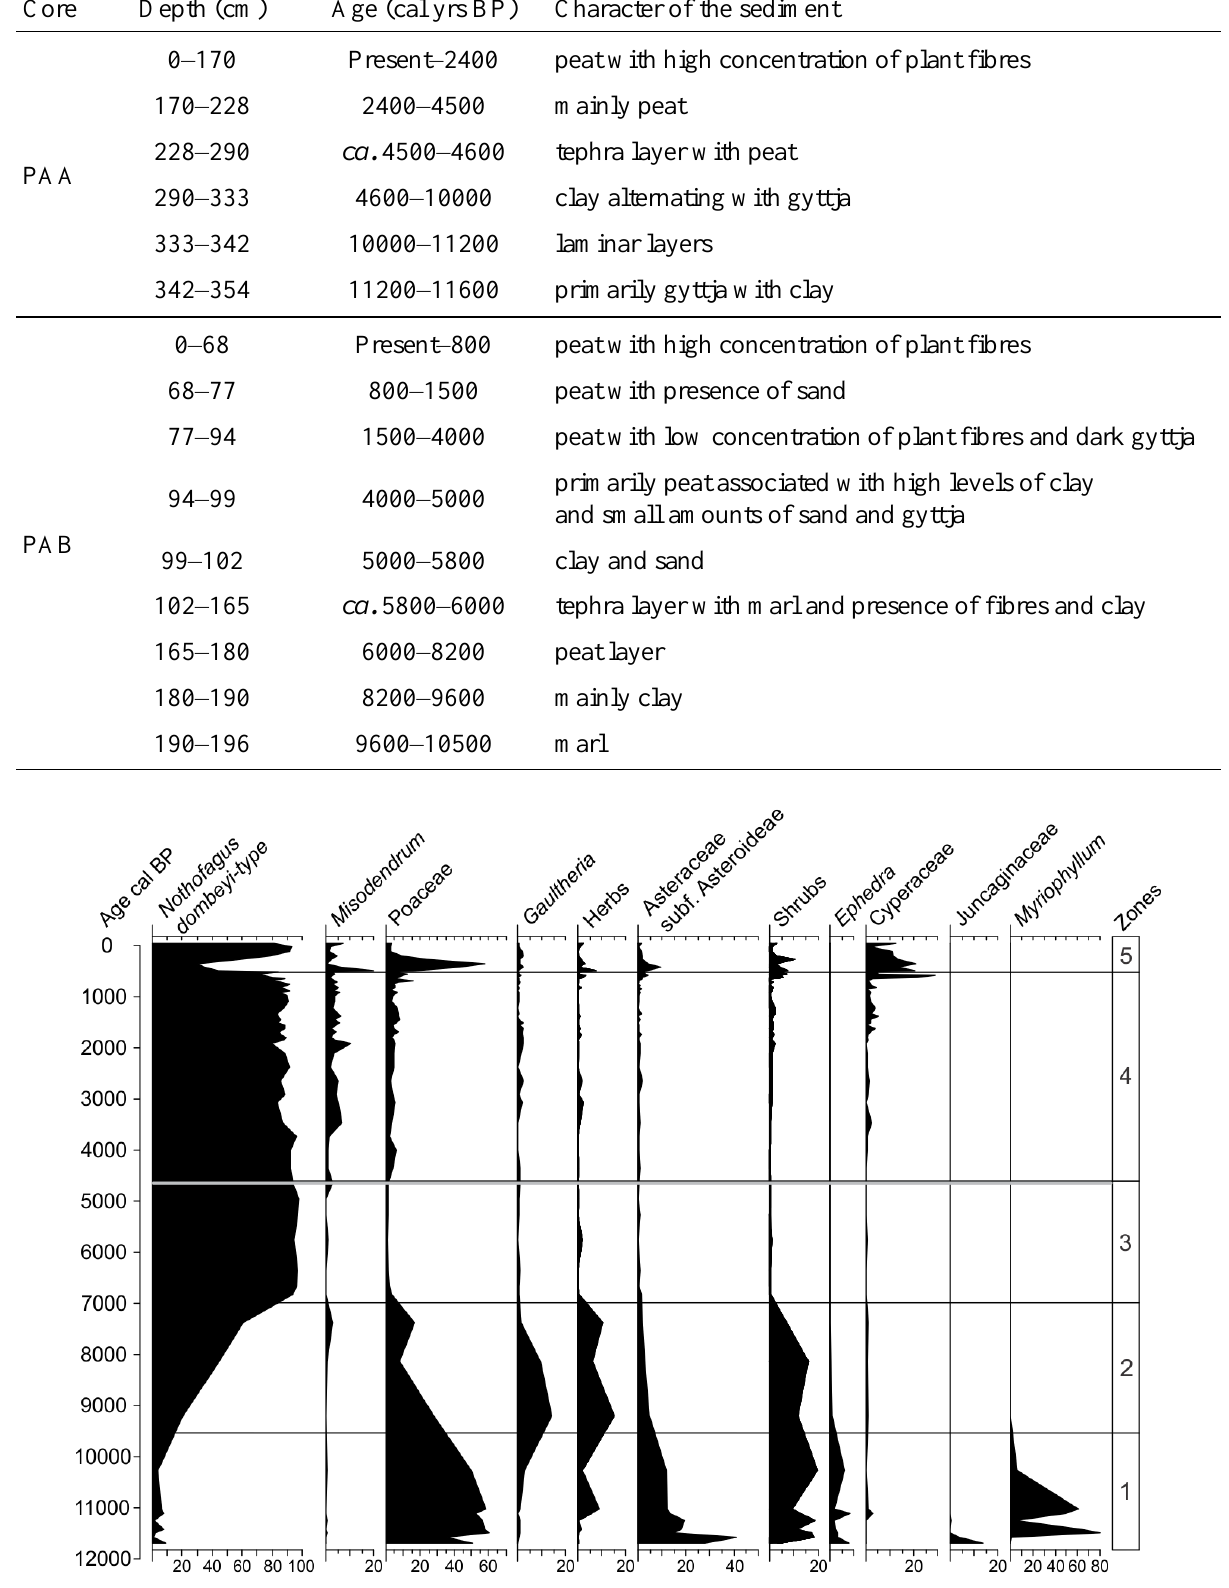
Figure 4. Península Avellaneda Alto (PAA) pollen diagram expressed in percentages (%). Pollen zones obtained by cluster analysis. The superposed grey line indicates the position of the tephra